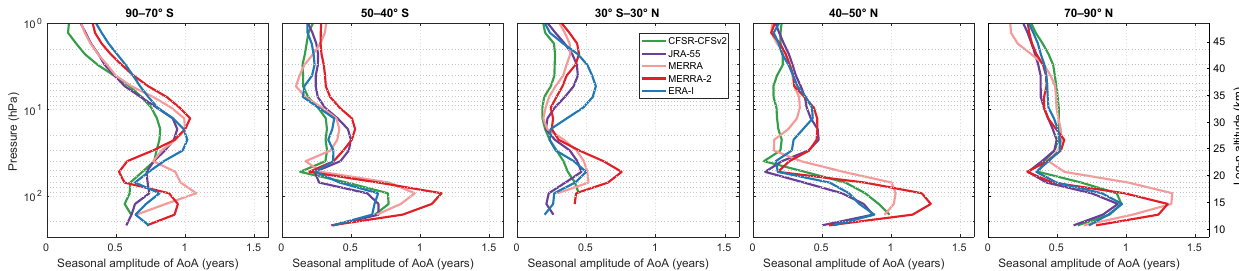
Figure 8. Time evolution of AoA (years) averaged from 30 to 5hPa (approximately 24 to 36km). Thick lines show model output smoothed with a 1-year running mean and line color codes as in previous figure. (a) Mean for the northern midlatitudes (40–50 ◦ N), where the symbols represent values derived from balloon observations of SF 6 (circles) and CO 2 (triangles) with color code showing the latitude of the measurements (according to the inset color bar) and outer error bars including sampling uncertainties (Engel et al., 2017). (b) Mean for the tropical latitudes (30 ◦ S–30 ◦ N), where the dashed lines show AoA using the tropical tropopause as reference. (c) Mean for the southern midlatitudes (50–40 ◦ S), where the thin lines show instantaneous model output every 5 days. Except for the dashed lines in panel (b) , all AoA values in this figure use the surface as reference.